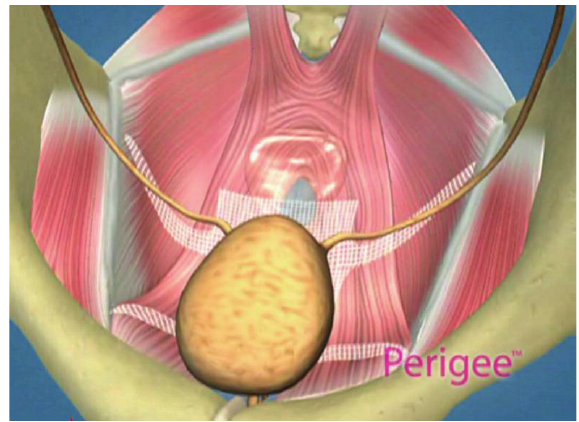
Figure 2: Final positioning of the mesh providing support under the